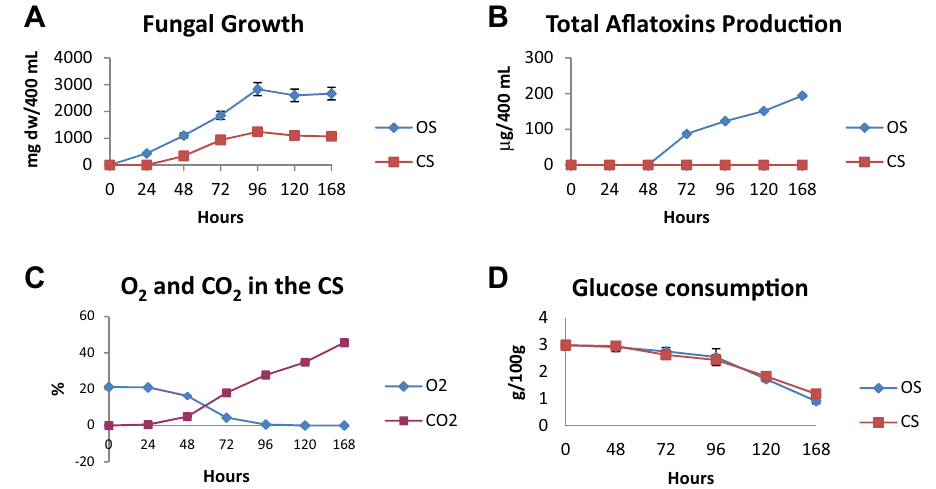
Figure 1. (A) Growth of Aspergillus parasiticus strain 2999 inoculated in PDB medium in the open system (OS) and closed system (CS) and incubated at 28 °C for 168 h. (B) Total aflatoxin production (B 1 + B 2 + G 1 + G 2 ) by Aspergillus parasiticus inoculated in PDB medium in OS and CS and incubated at 28 °C for 168 h. (C) Trend of the percentage (%) of O 2 and CO 2 during the time course of the growth of Aspergillus parasiticus inoculated in PDB medium in B CS and incubated at 28 °C for 168 h, in the OS the percentage of O 2 and CO 2 remain the same. (D) Analysis of glucose consumption during the growth of Aspergillus parasiticus inoculated in PDB medium in OS and CS and incubated at 28 °C for 168 h. Each value is the mean of three determinations ±